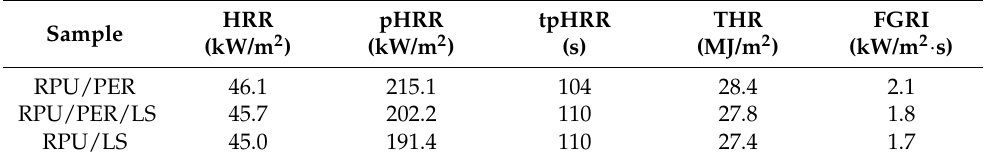
Table 3. Effect of LS as a char forming agent on heat transfer between the gaseous and condensed phases.